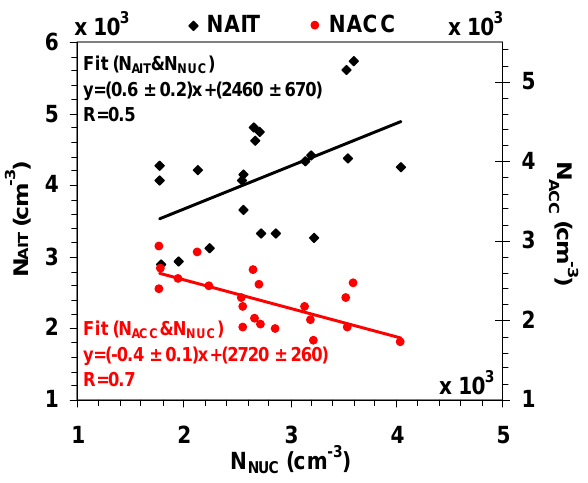
Fig. 4. The linear fits between the monthly mean N AIT and N NUC (black line) and between the monthly mean N ACC and N NUC (red line). The coefficient of correlation and the standard deviation of the slope and the intercept are also shown for both linear fits.